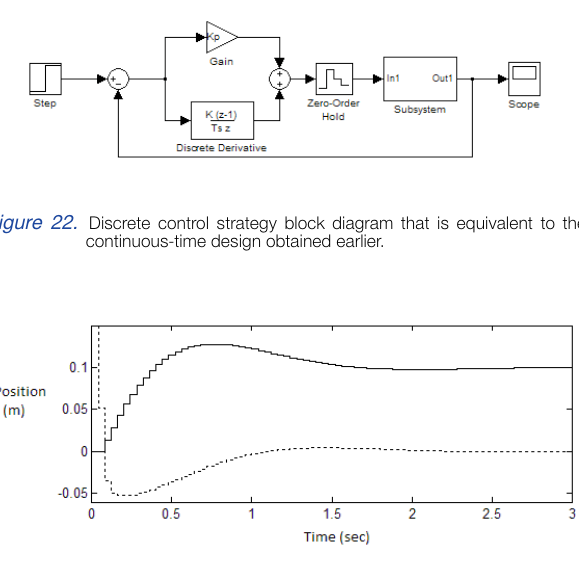
Figure 23: Simulated discrete step response of the linear P‐D control